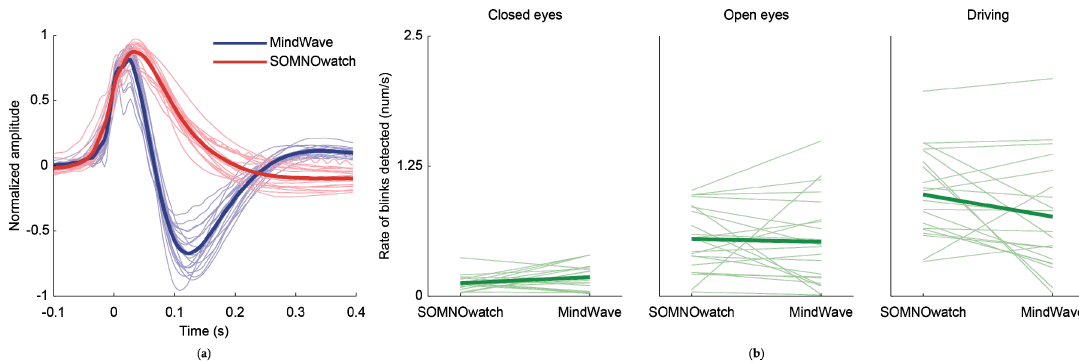
Figure 6. Waveform and rate of detected blinks. Average waveforms and blink detection rate for each individual participant ( N = 21, thin lines) and the population mean (thick lines). ( a ) Average waveform, with the timepoint of crossing the amplitude threshold (see Methods section) aligned to zero. Amplitudes of individual artifacts are normalized to a maximum value of 1. The different shape of blinks is apparent. ( b ) Blink detection rate obtained from the closed eyes ( left ), open eyes ( center ), and driving ( right ) tasks. Thin lines show individual participants and thick lines are the average result.